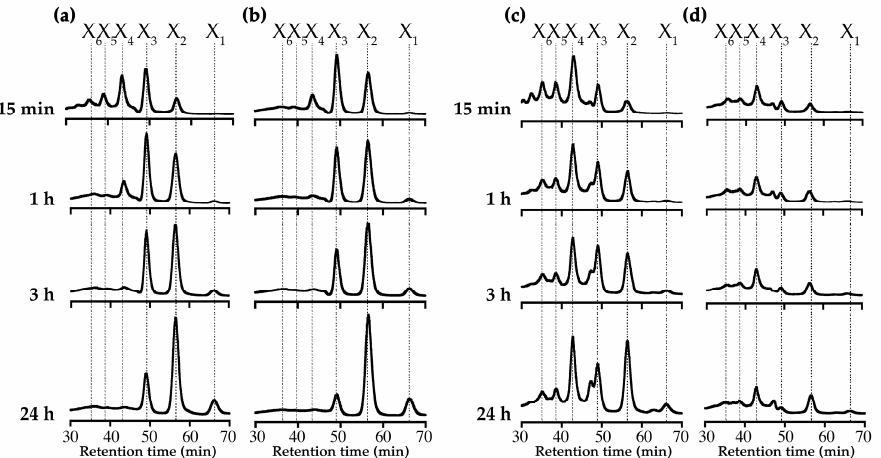
Figure 5. Product analysis of xylan degradation. ( a , b ) products formed from hydrolysis of beechwood xylan by XynRA2 and XynRA2 ∆ CBM, respectively; ( c , d ) products formed from hydrolysis of oat-spelt xylan by XynRA2 and XynRA2 ∆ CBM, respectively. The product peaks shown in this figure were normalized.